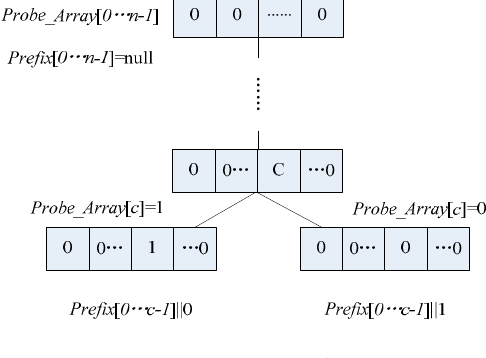
Figure 4. Array storage diagram.